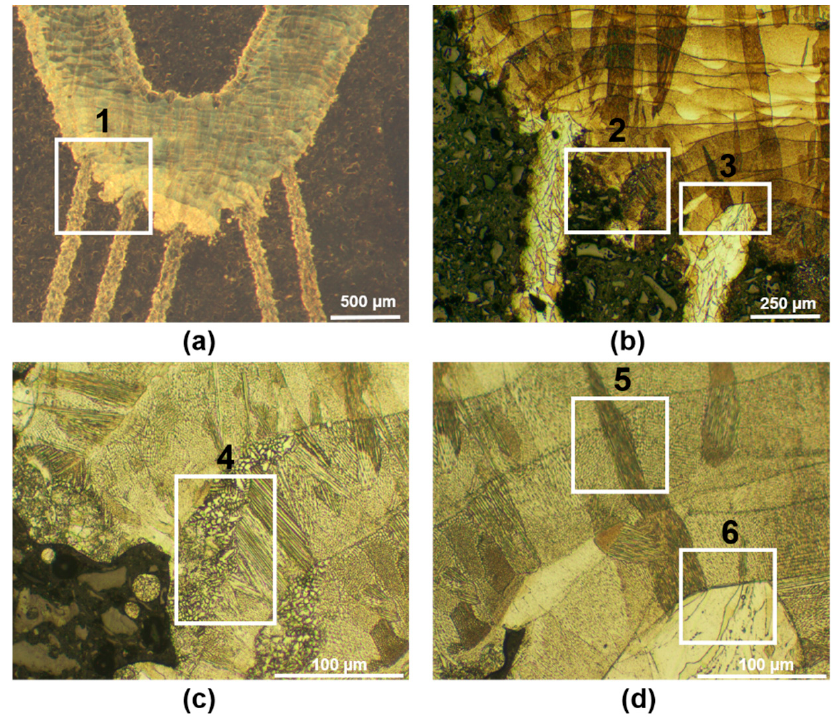
Figure 11. Light microscopy images taken at different magnifications representing the boundary between support and specimen for ( a ) line support with ( b ) two regions highlighted, and these are shown in detail in ( c , d ) .